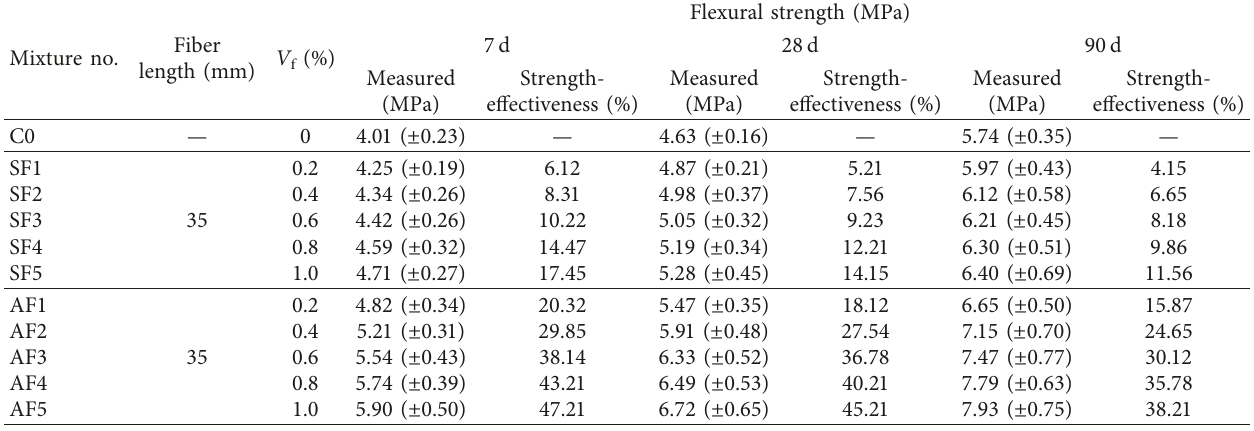
Table 7: Result of flexural strength tests.